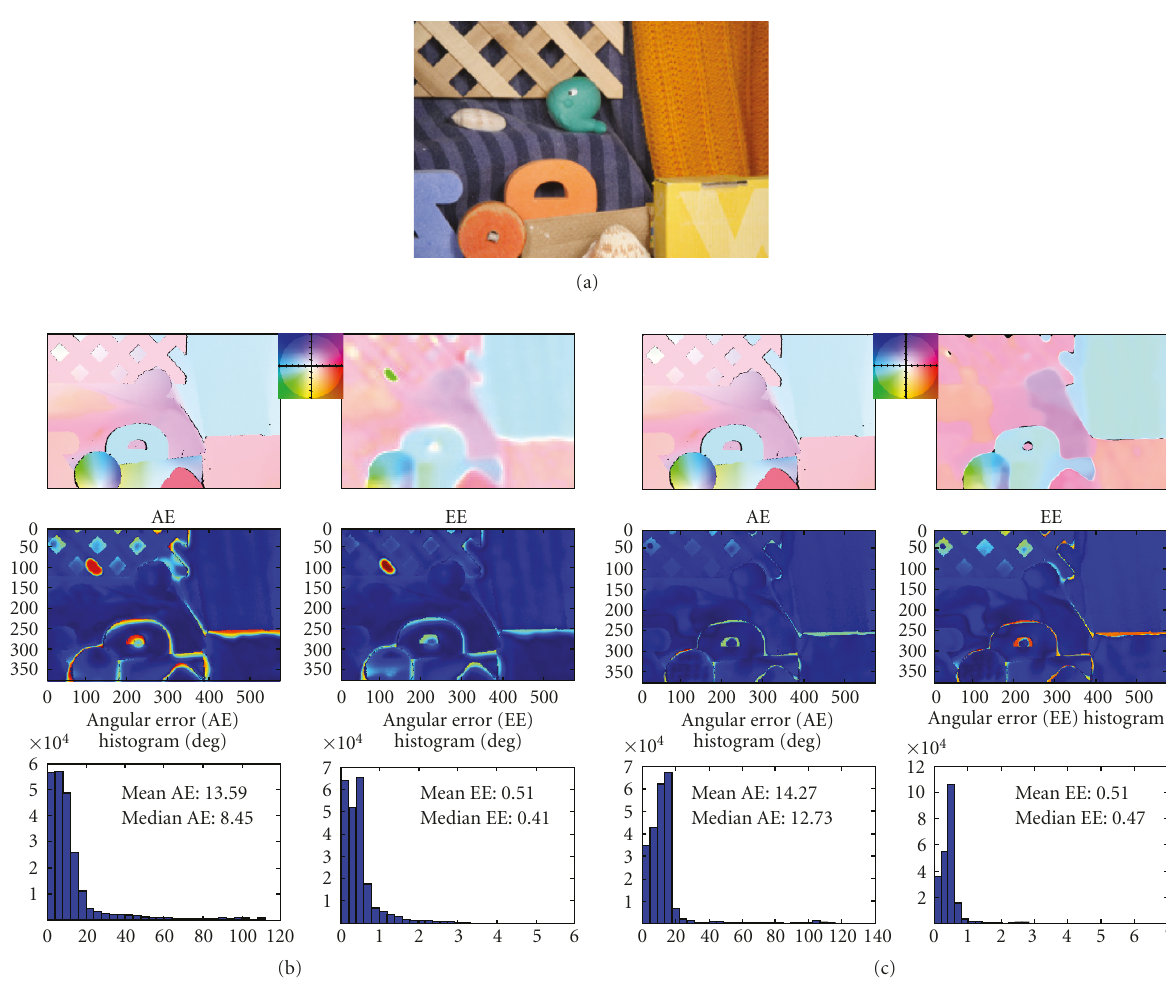
Figure 9: The proposed biologically inspired motion processing scheme has also been applied to realistic natural images sequences recently proposed to benchmark state-of-the-art computer vision algorithms [13]. (a) One frame of the RubberWhale sequence from the Baker et al. image sequence database. (b and c) In the top row of each subfigure, the ground truth optic flow (left) and simulation results for model MT neurons (right) are shown. The bottom row shows the angular error (AE) as well as the endpoint error (EE). The center row shows the errors as a heat map while in the bottom row the error distribution is shown. The error values shown only incorporate those pixel positions that were defined in the ground truth, and nondefined occlusion regions were excluded from the statistics. On the left (b) a variant of the model without recurrent normalization from pooling neuronal activity in area MT ( δ MT 2 = 0) is used whereas in the figures on the right (c) a parameterization with δ MT 2 > 0 produces results with higher accuracy for homogeneous regions, while error measures increase at motion discontinuities. Considering the error distributions for the di ff erent measures in the bottom row shows that the spread is reduced for the pool normalization. However, those errors remaining deviate from zero and thus generate an overall weaker performance. These errors are focused mainly around discontinuities as indicated by the heat map